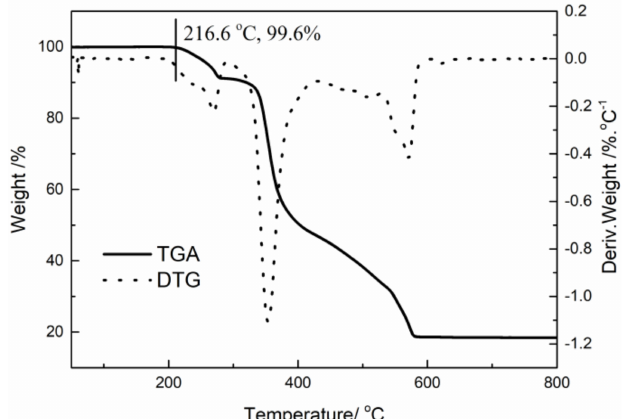
Figure 1. The TGA and DTG curves of ZnOr 2 from room temperature to 800 ◦ C at a heating rate of 10 ◦ C/min in an air